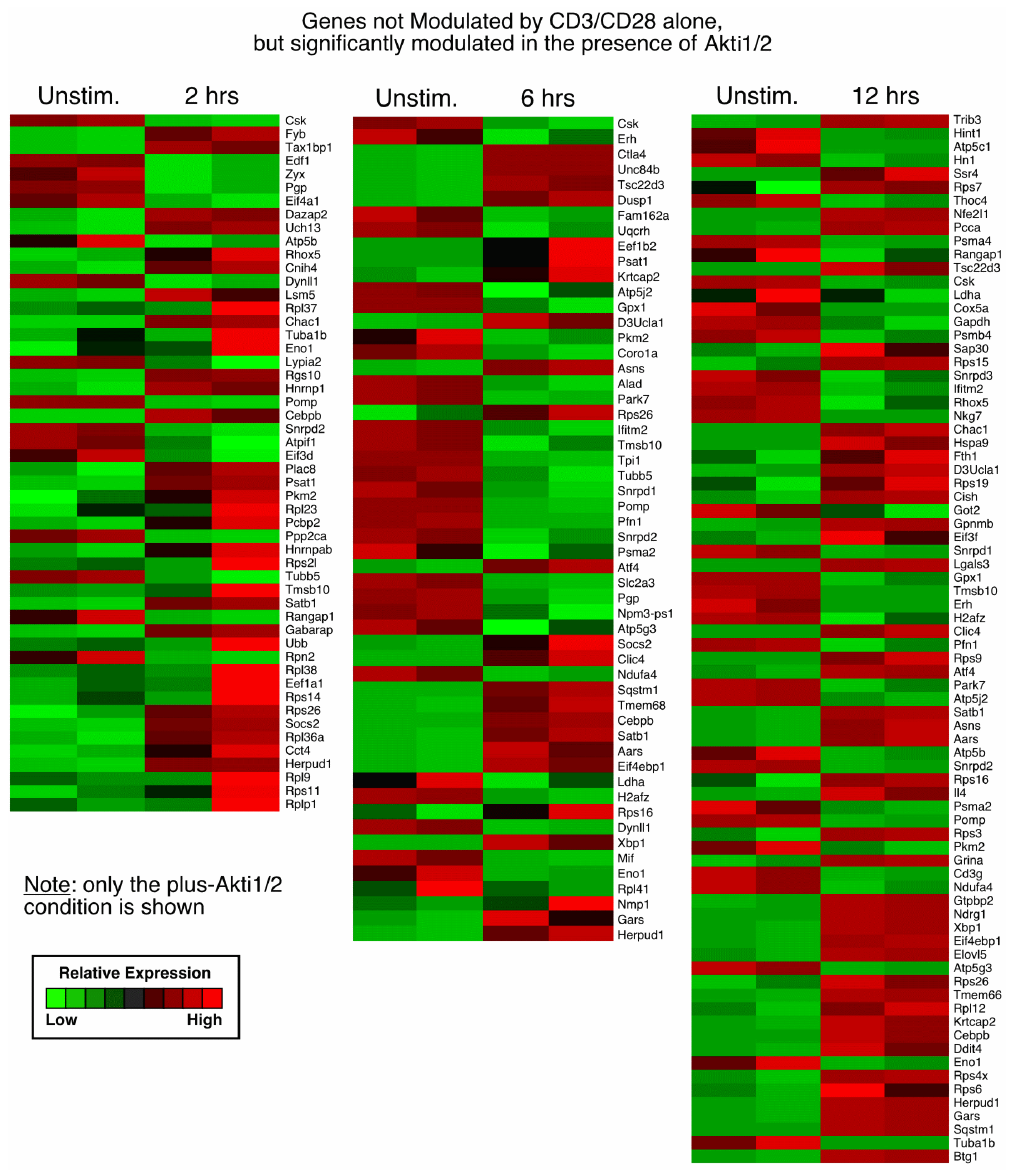
Supplementary Figure 3. Genes significantly modulated by Akti1/2 alone. Each row represents a gene and each column shows one of the duplicates from two different groups (from left to right 0 h vs. 2 h, 0 h vs. 6 h, 0 h vs.12 h). The red and green colors reflect high and low expression levels,